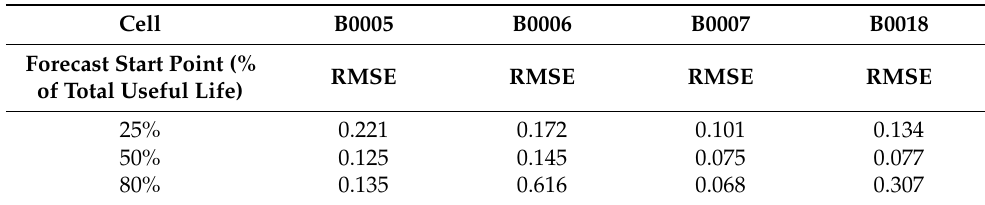
Table 4. Comparative results between the experimental measurements of the cell terminal voltage vs. SOC and the Nernst equation adjusted with the proposed degradation model with a discharge current of 2 A (C-rate of